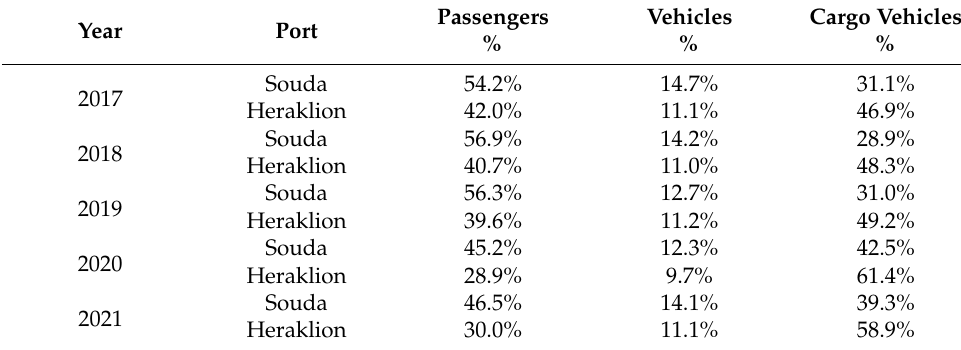
Table 8. Sharing of annual revenue for passenger ferries per transportation category.